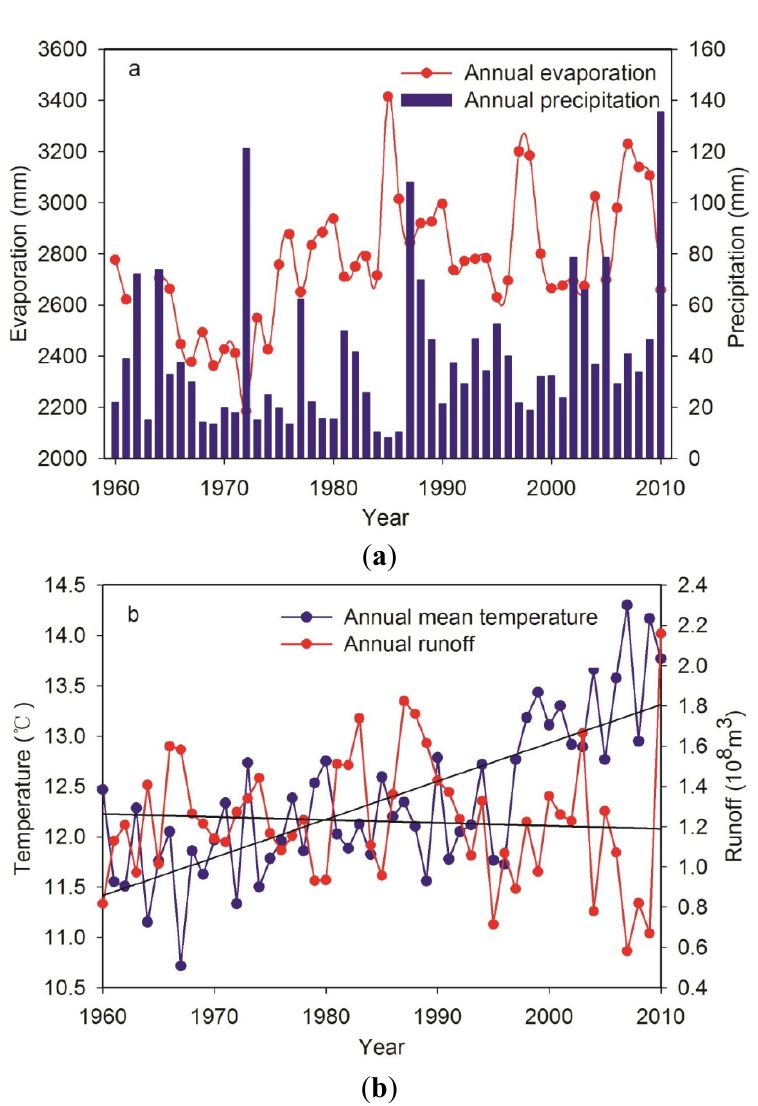
Figure 3. Variations in annual precipitation and evaporation ( a ); annual mean temperature, and annual runoff ( b ) in the Qira